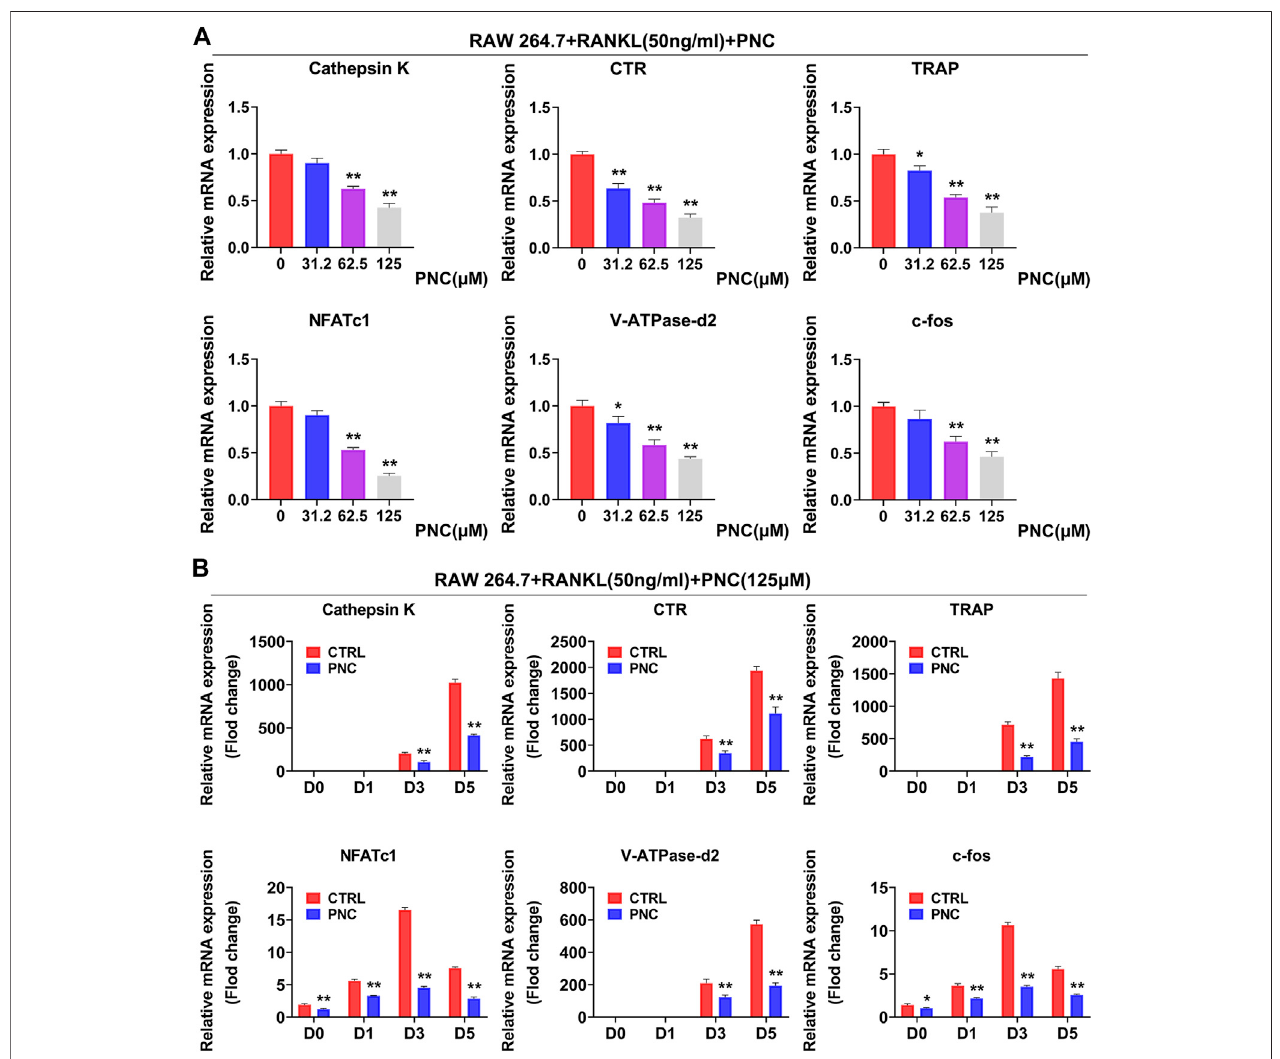
FIGURE 2 | PNC impaired RANKL-mediated expressions of speci fi c genes in osteoclastogenesis. (A) Diverse concentration of PNC (0, 32.2, 62.5, 125 μ M) mitigatedthetranscriptionofosteoclast-speci fi cgenes,includingCTR,CathepsinK,TRAP,V-ATPase-d2,NFATc1,andc-fos. (B) withorwithout125 μ MPNC,for0,1, 3, or 5 days separately. Expressions ofspeci fi c genes associated in osteoclast formation were determined through real-time PCR and normalized to β -actin. ** p < 0.05, ** p < 0.01 compared to the control group.